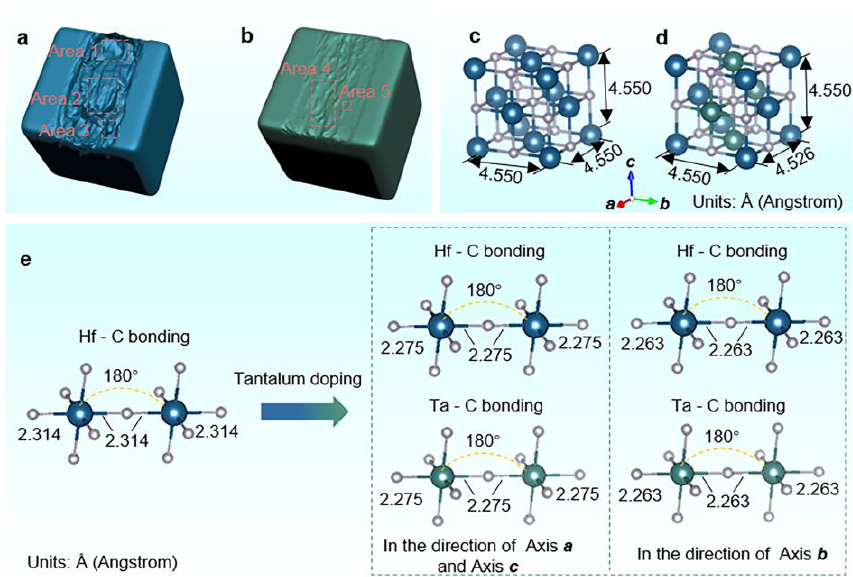
Figure 15. Wear mechanism diagram of ( a ) Substrate and ( b ) Coatings; crystal structure of ( c ) HfC and ( d ) Hf 0.5 Ta 0.5 C; ( e ) Change of bond length.